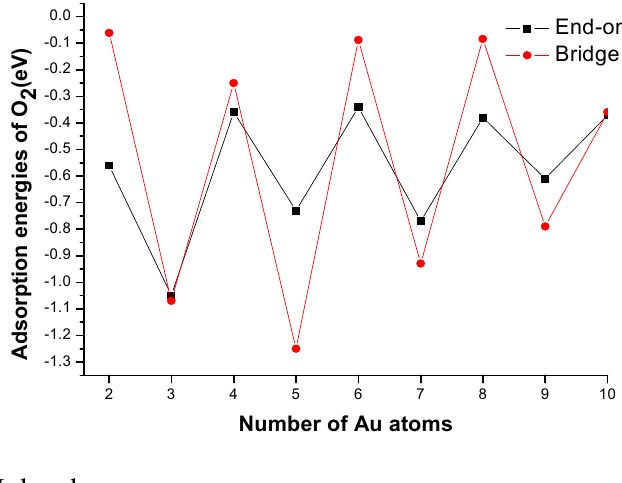
Figure 2. Variation of adsorption energy of molecular oxygen with cluster